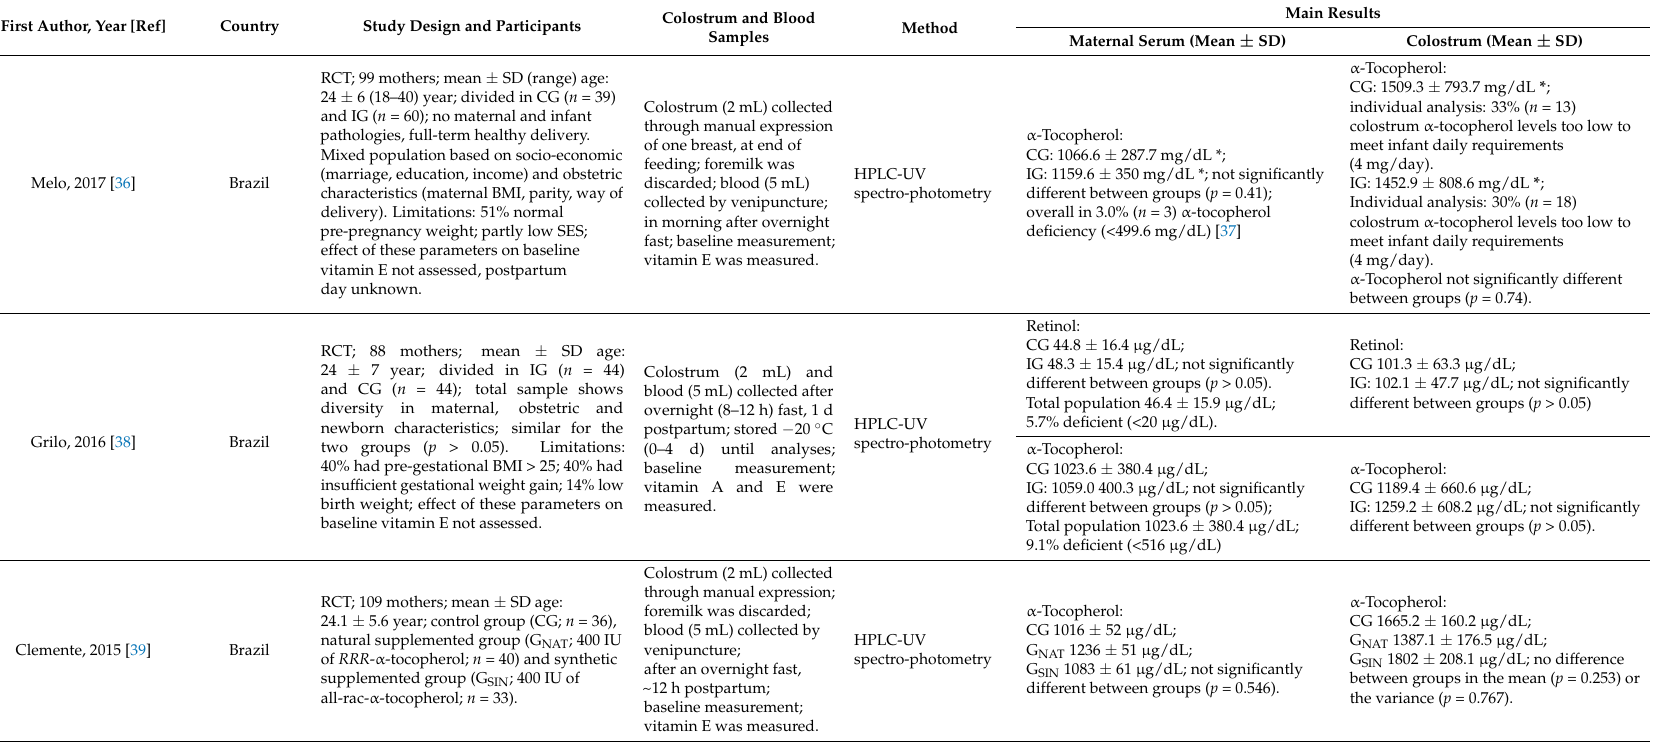
Table 3. Characteristics of publications on the relationship between maternal vitamin state and colostrum vitamin